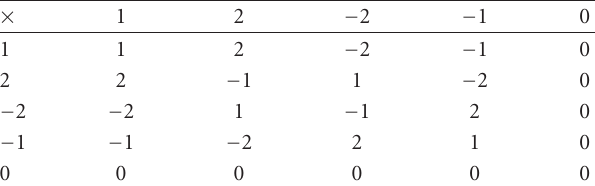
x k and k +1 into